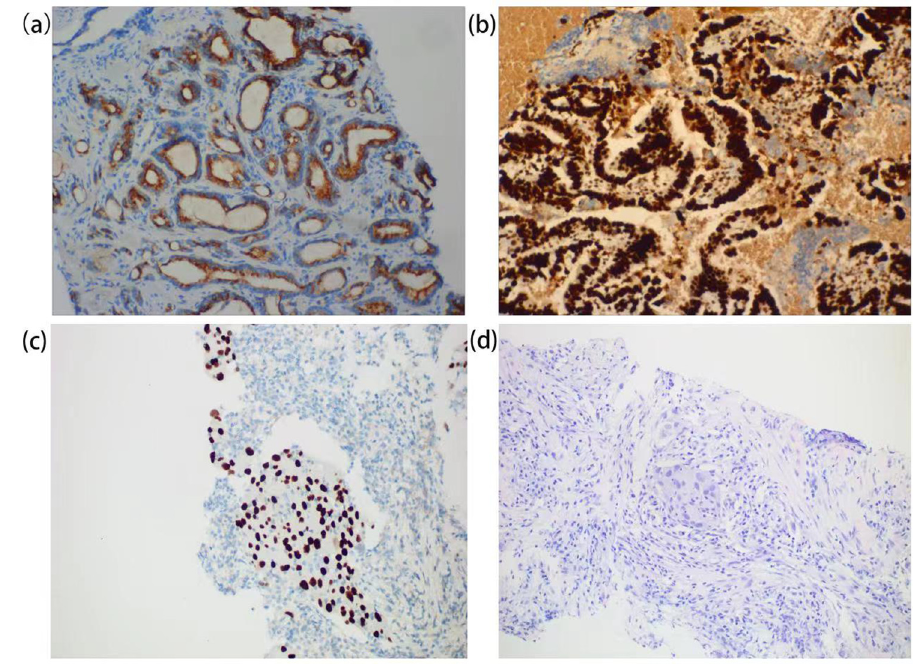
Figure 3: Histopathological section of the three carcinomas. ( a ) Shows P504S (+) in prostate adenocarcinoma. ( b ) Shows TTF - 1 (+) in bladder urothelial carcinoma. ( c and d ) Show GATA - 3 (+) and HE staining in NSCLC,